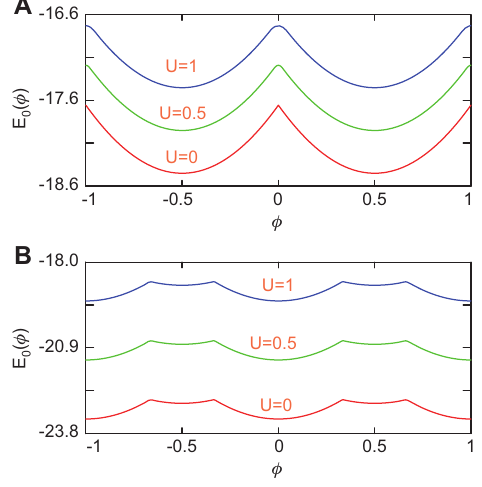
Figure 10 Ground state energy levels as a function of fl ux φ for some perfect cylinders with N = 5 and M = 2. The red, green, and blue curves correspond to U = 0, 0.5, and 1, respectively. (A) Quarter-fi lled case and (B) Half-fi lled case.